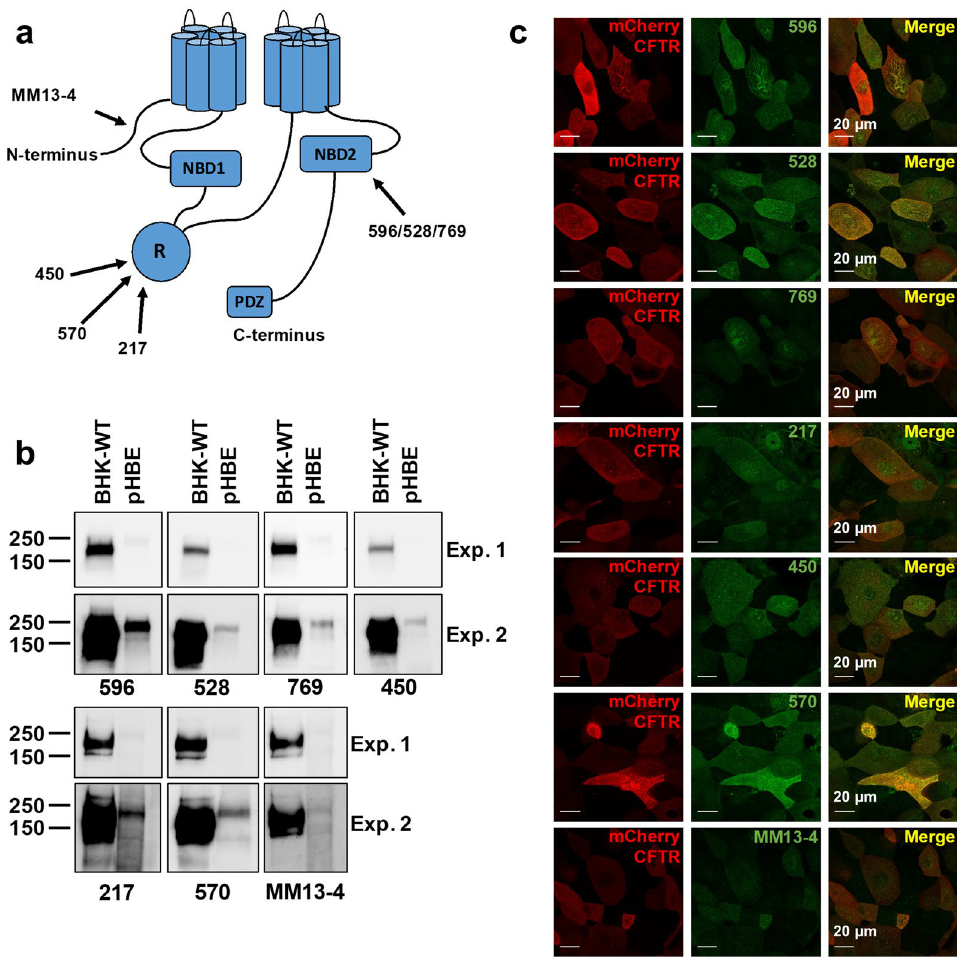
Figure 1. Immunodetection of CFTR. ( a ) Cartoon showing locations of epitopes for the seven anti-CFTR antibodies used in this study. ( b ) Immunoblots of lysates after SDS-PAGE probed for CFTR using each antibody. BHK-WT cells were stably transfected with CFTR. Well differentiated primary bronchial epithelial (HBE) cells expressed endogenous CFTR. Protein (BHK-10 µg, HBE-40 µg) was detected after short and long exposures (Exp.1 and 2, respectively). Blots were cropped. ( c ) Confocal images of HBEs at the apical membrane after transduction with adenoviral mCherry-WTCFTR. Cells were cultured at the ALI for 10–15 days and immunostained on intact membrane